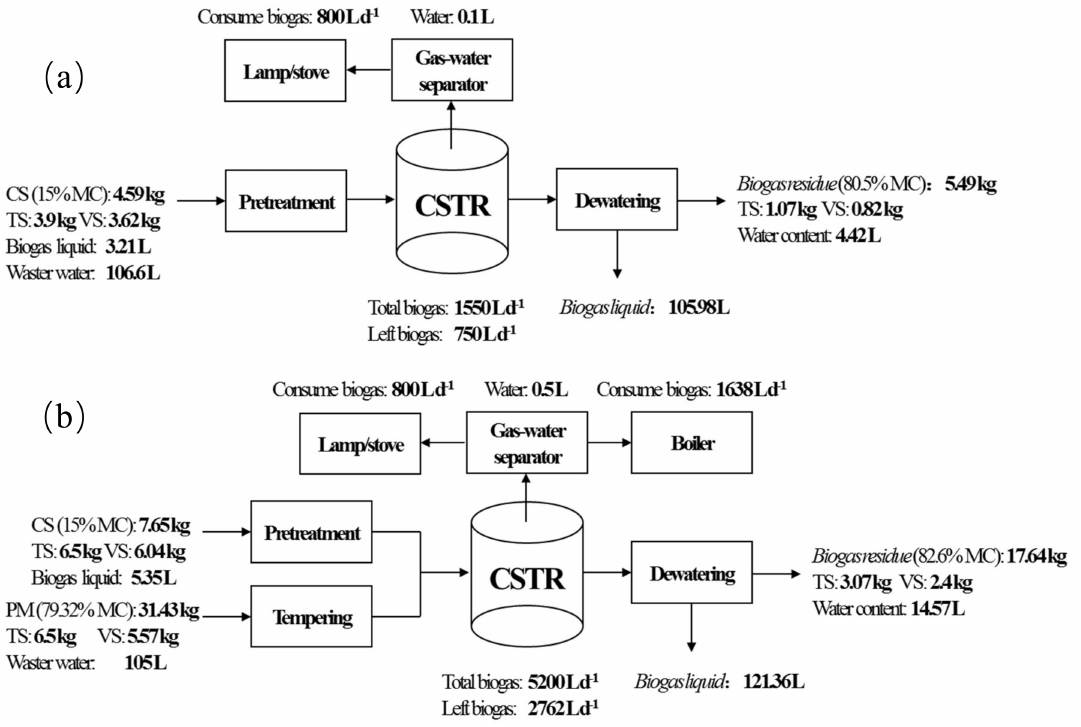
Figure 7. Mass balance of two sections, ( a ) stage III, solely CS at 3% solid content and ( b ) stage VII, 1:1 mixture ratio of CS with PM at 10% solid content (Moisture content,